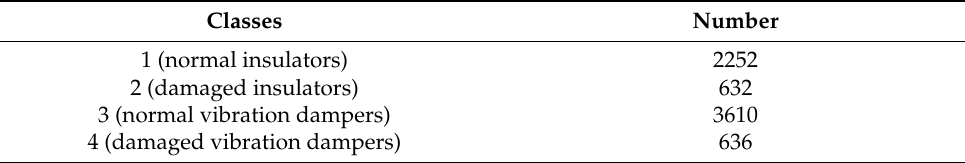
Table 1. Label numbers per class.